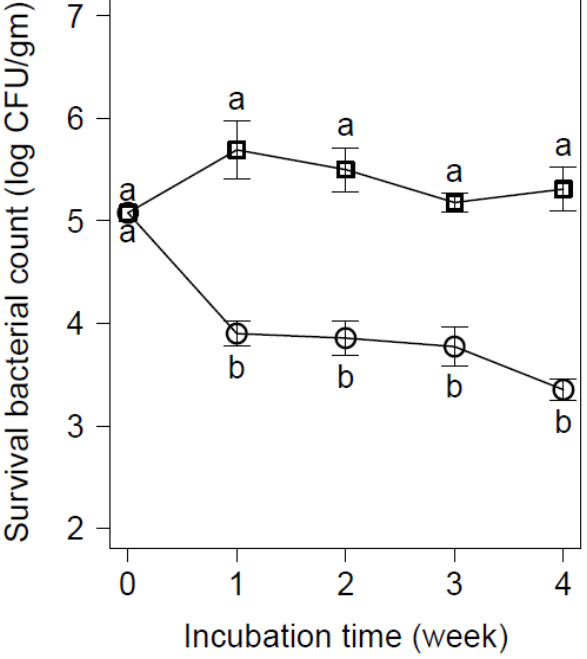
Figure 4. Inhibitory effect of D-tryptophan (0 mM D- Trp, □; 40 mM D - Trp, Ο) on the viable counts of E. coli O 26 inoculated into vanilla ice cream at −20 °C. Values are the mean ± standard deviation of three independent trials. Values with different letters are significantly different ( p < 0.05).